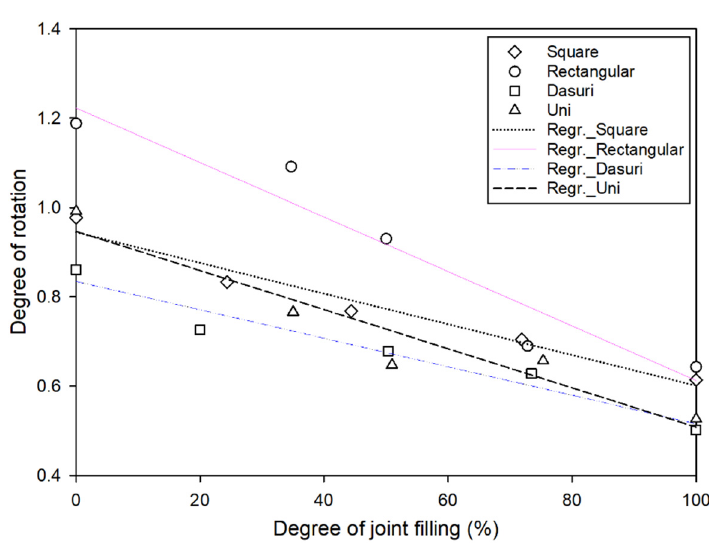
Figure 9. Rotational angles according to block shape and degree of joint